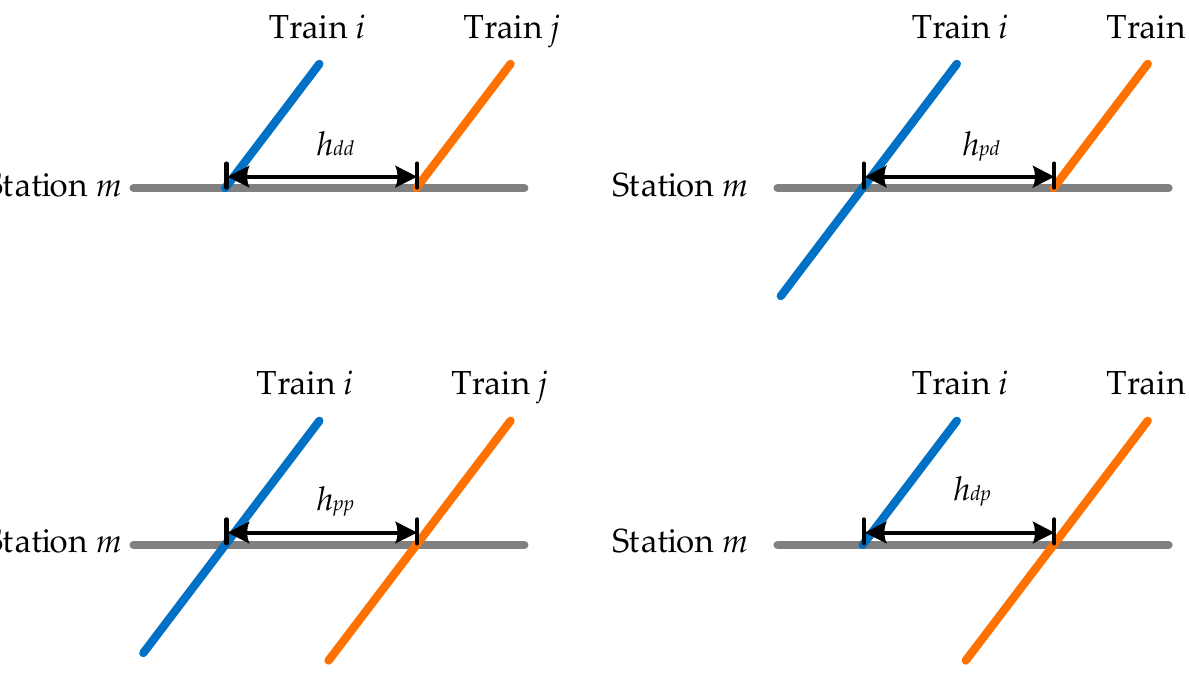
Figure 3. Departure headway in different situations of train stops.